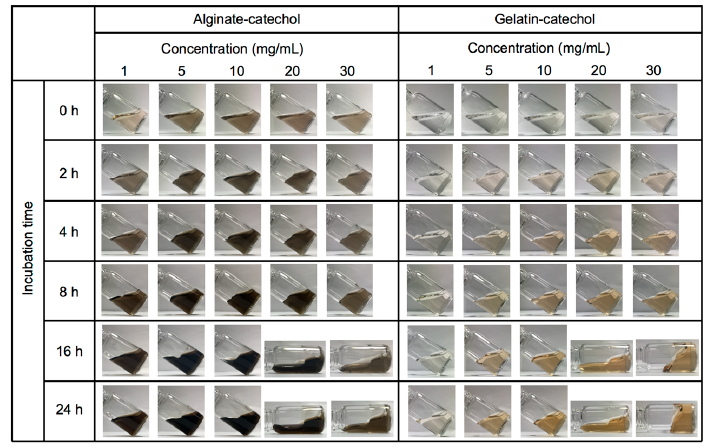
Figure 2. Photographs of gelation of AC and GC at various concentrations.